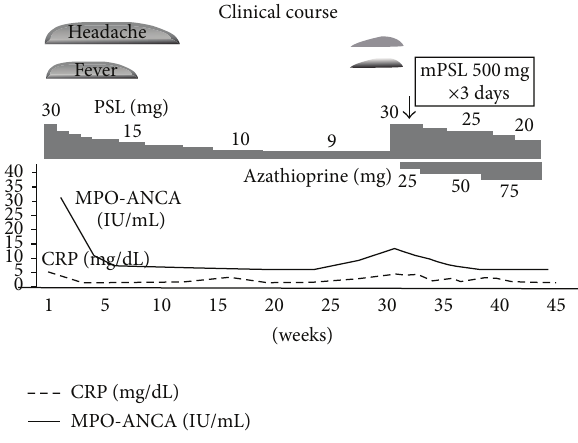
Figure 6: Clinical course of the present